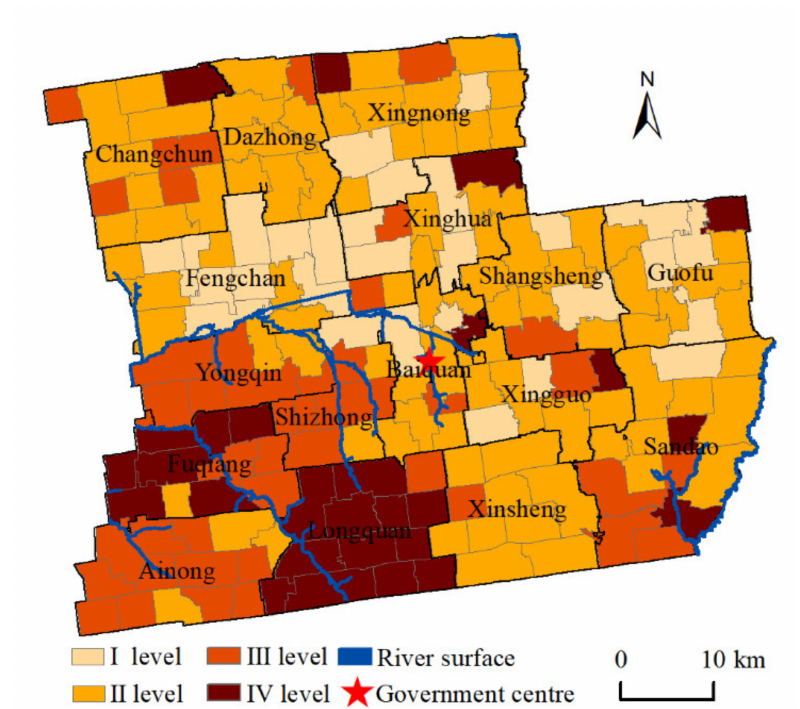
Figure 4. Distribution of the intensive degrees of cultivated land